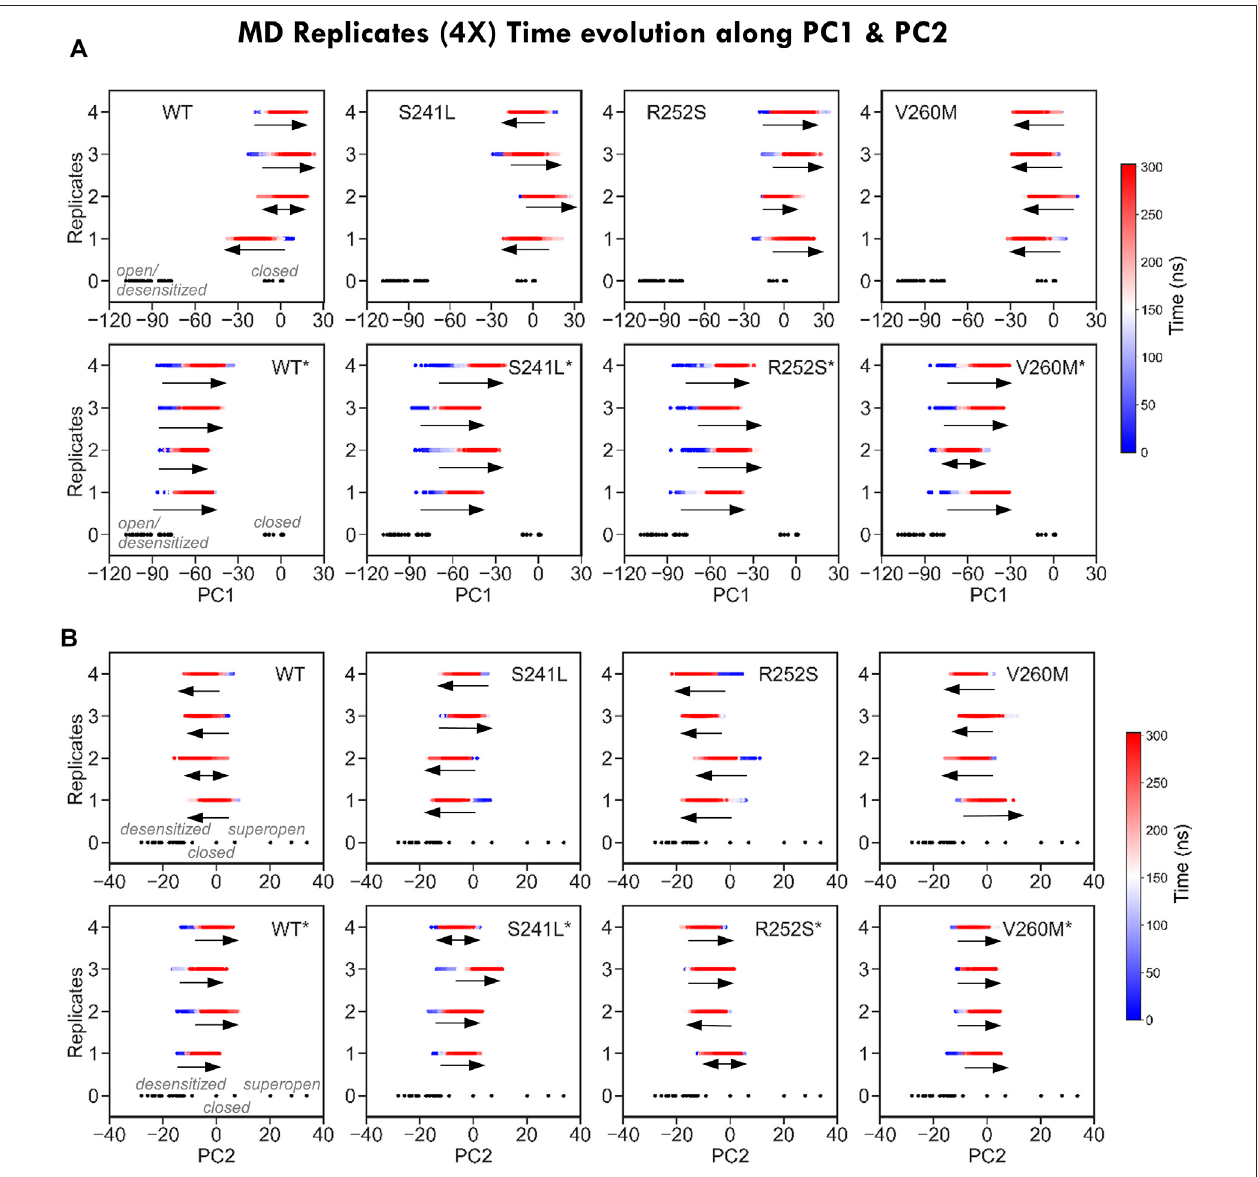
FIGURE4| Time evolution ofMD replicates alongPC1 and PC2. (A) Time evolution ofMD trajectoriesalongPC1, whichseparatesclosed from open/desensitized structures,foreachofthefourreplicatesfromeachsystem.Notehowforsimulationsfromtheclosedstate( top ),trajectoriesevolveinbothclosedandopen/desensitized directionsorstayaroundthestartingstructure,withtheexceptionofV260M,inwhichallrunsproceedtowardtheopenregiontotheleft.Onthecontrary,alldesensitized state simulations ( bottom ) progress in the closing direction. (B) Time evolution of MD trajectories along PC2, which separates closed from open/desensitized structures, for each of the four replicates from each system. Trajectories stay or evolve toward pore closing, with the exception of S241L and V260M, which have replicates progressing toward opening. On contrast, most simulations from the desensitized state ( bottom ) evolve toward pore opening, except for R252S*.